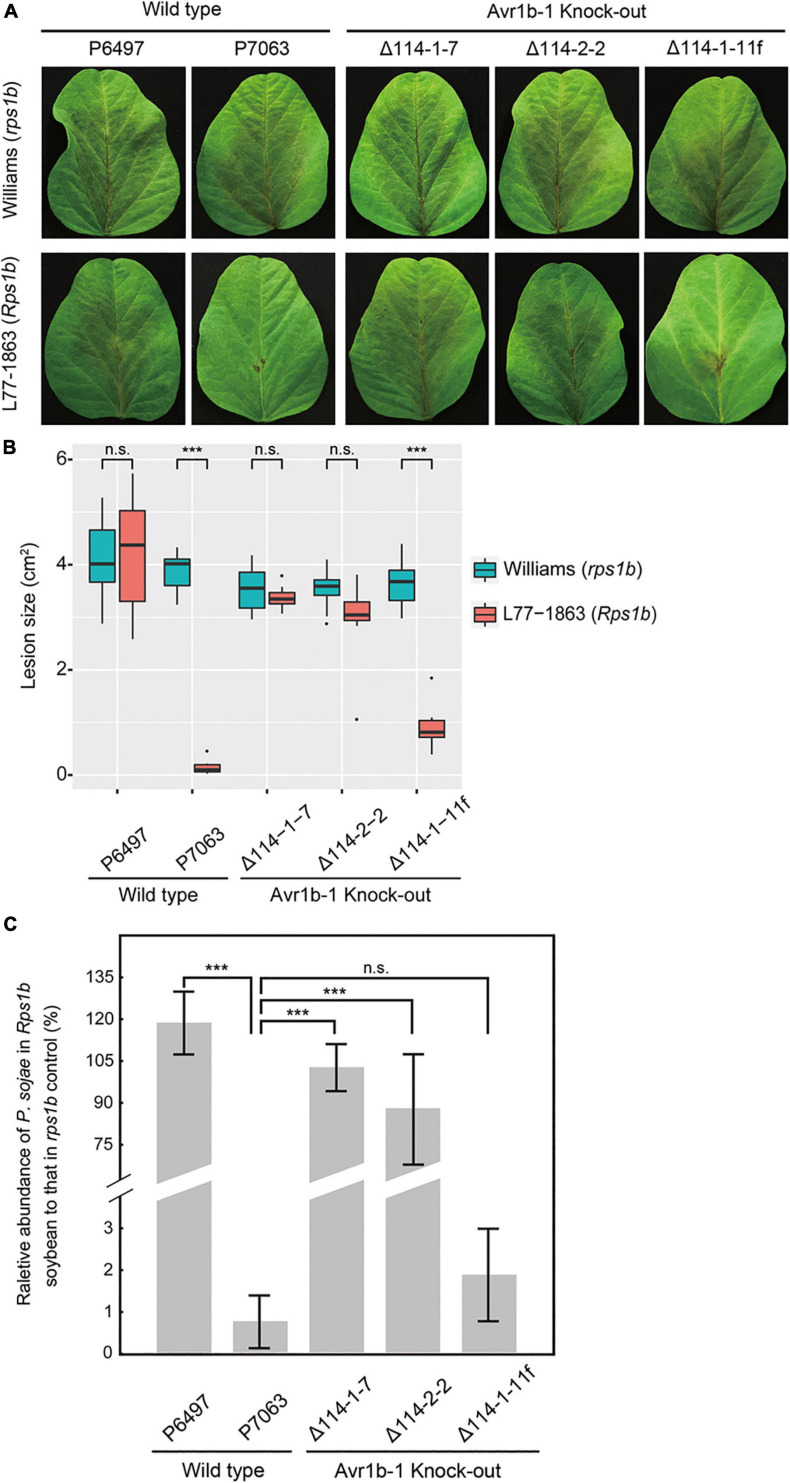
Avirulence phenotypes of Avr1b-1 knock-out transformants measured by detached leaf inoculations. (A) Soybean leaf lesions 3 days after zoospore inoculation of Williams (rps) or L77-1863 (Rps1b) unifoliate leaves. (B) Sizes of lesions after 3 days. Lesions on eight unifoliate leaves were measured in each of three independent experiments. The relative lesion size was measured from photographs with ImageJ software. Lesion sizes were compared between Williams (rps) and L77-1863 (Rps1b) using the Wilcoxon rank sum test. ***P < 0.001, n.s. P > 0.1. (C) Avirulence phenotypes of Avr1b-1 knock-out transformants measured by real-time PCR-based quantification of P. sojae genomic DNA in infected tissue. Proliferation of P. sojae was plotted as the ratio between the abundance of PsActin relative to GmActin DNA in infected L77-1863 leaves compared with that in infected Williams leaves, at 72 hpi. Error bars represent standard deviation of three technical replicates. This experiment was replicated three times. Error bars represent the mean ± standard deviation. P-values were determined by the Wilcoxon rank sum test; *** indicates P < 0.001.